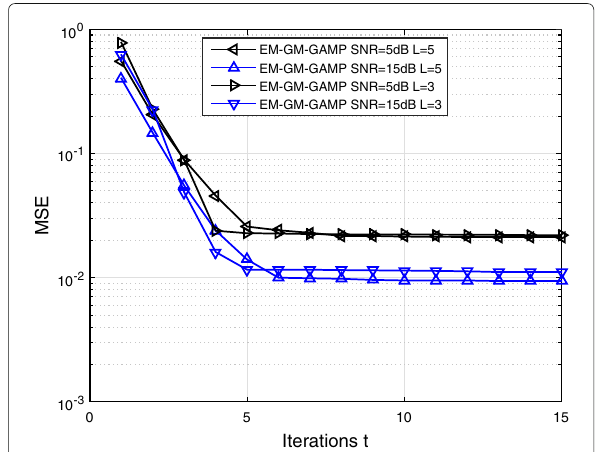
Fig. 2 MSE performance of EM-GAMP algorithm as functions of the iterations